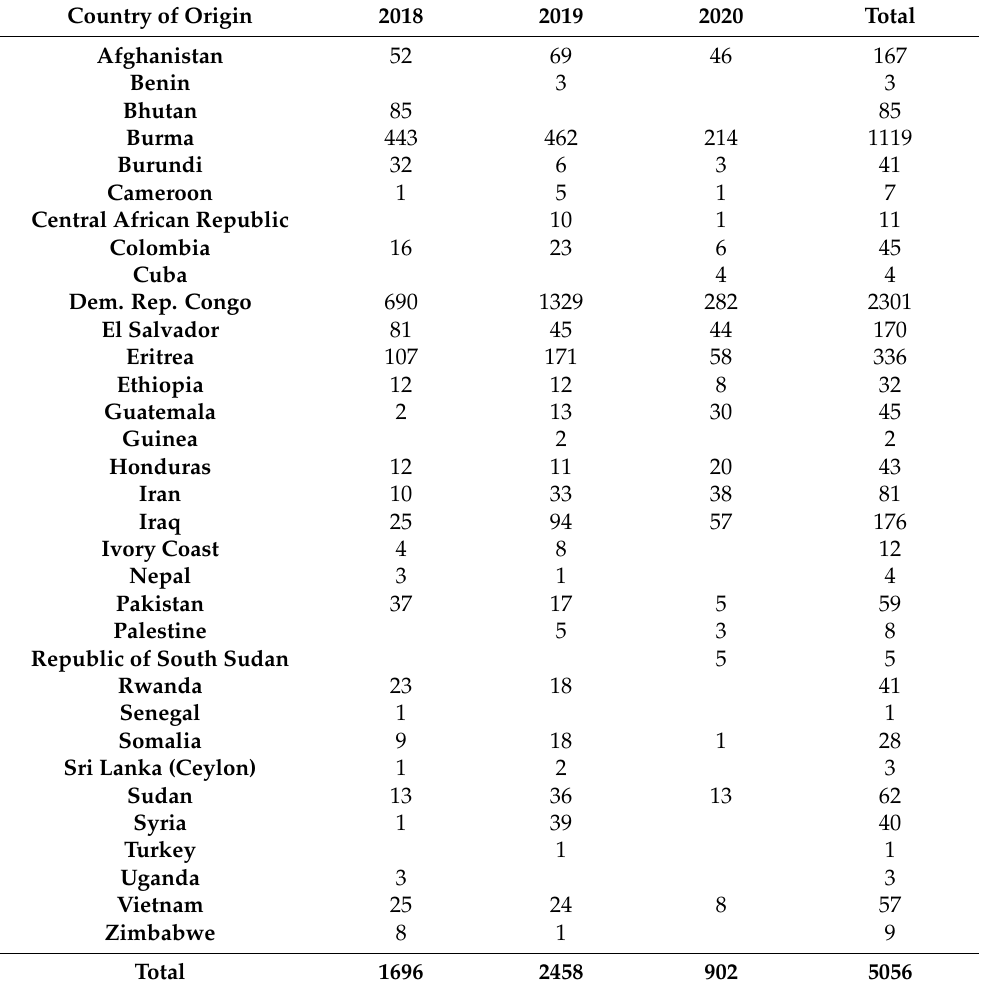
Table 1. Refugee Arrivals by country of origin in Texas between 2018 and 2020 (Refugee Processing Center, 2021) a